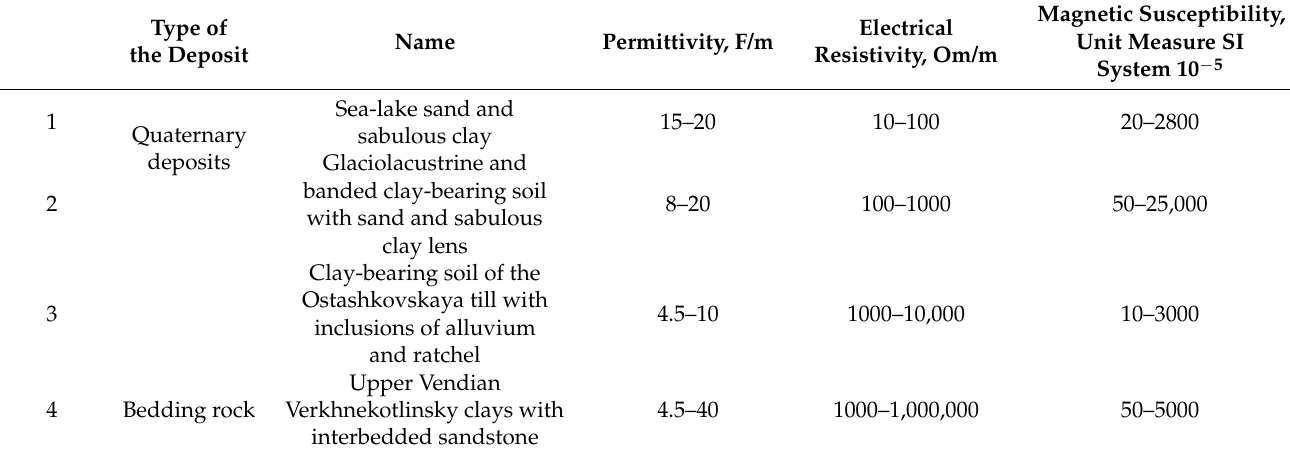
Table 1. Average values of electric and magnetic parameters of soils characteristic of the studied area for the frequency of 1 kHz. Type